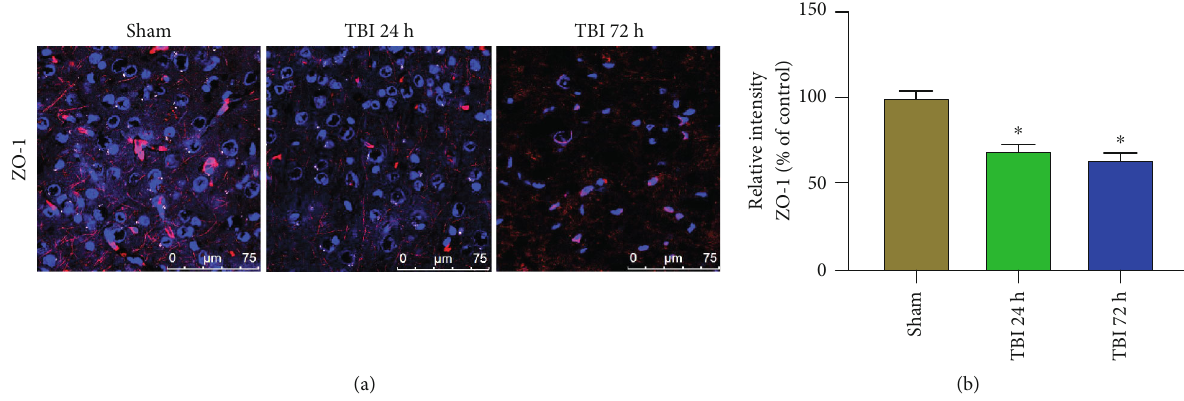
Figure 7: Acute TBI a ff ects ZO-1 expression in the brain. ZO-1 expression was analyzed in the frozen sections (20 μ m) of the brains after 24h and 72 h of weight drop-induced TBI and sham control mouse brains without TBI ( n = 3 mice/group). Representative images and immunoreactivity intensity bar graphs show the derangement of ZO-1 expression (red color) in 24h and 72 h acute TBI brains as compared with sham control brains without TBI ( ∗ p < 0 : 05 , sham control vs. TBI). The cellular nuclei were stained with DAPI (blue color). Photomicrograph original magni fi